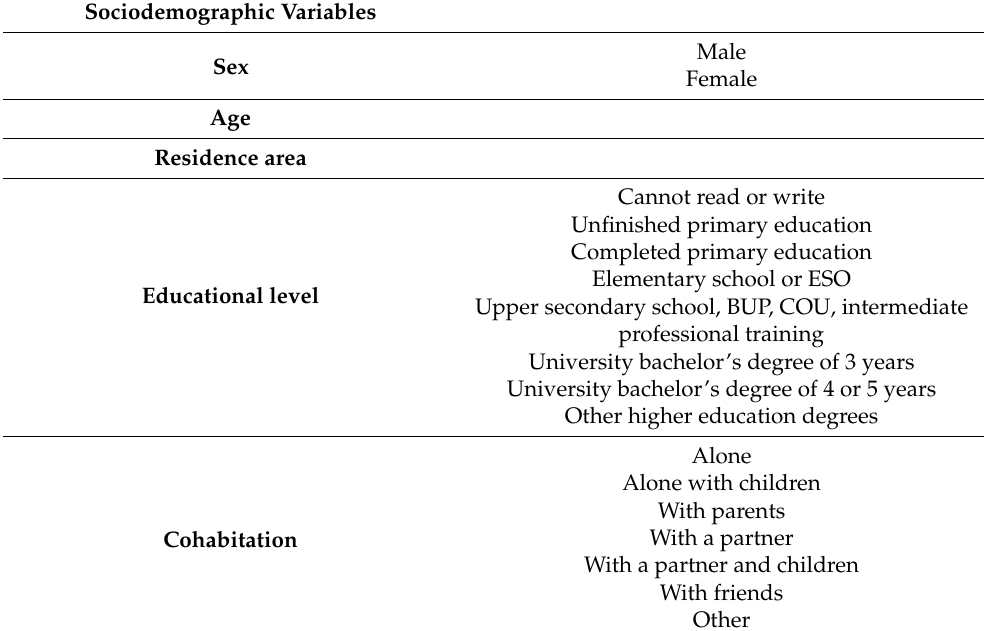
Table A1. Baseline sociodemographic and clinical information routinely collected by survey in outpatient drug dependence care centres in